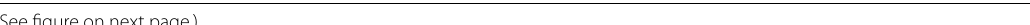
6/ = 6/group. C Schematic illustration of brain tissue = 6/group. F The mRNA levels of CLR and RAMP1 in VN. n 6/ = = 3/group. Results are mean SD. = ±